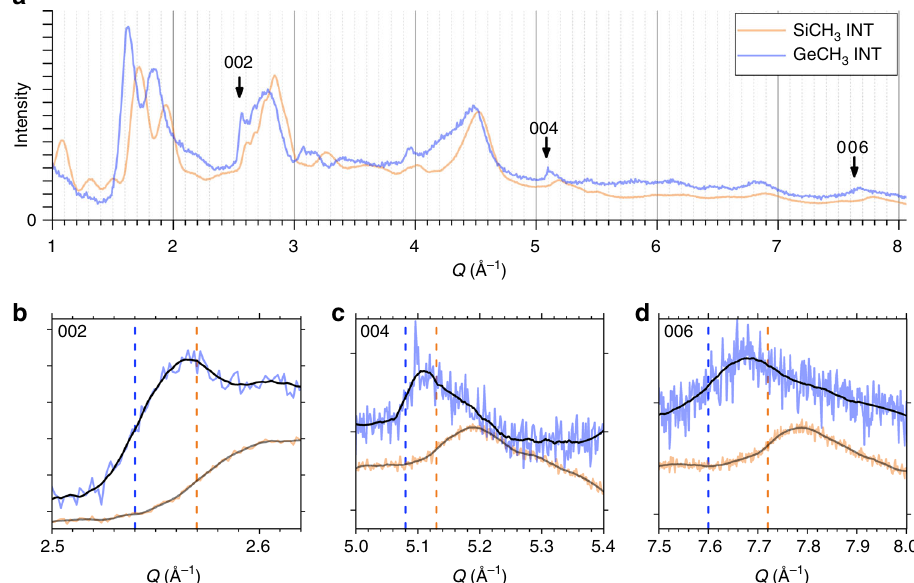
Fig. 3 The period of methylated imogolite nanotube from powder WAXS diagrams. a WAXS of methylated Si(Ge)CH 3 INT powders. Insets b – d highlight 00 l asymmetrical peaks. Black curves are the result of the Savitzky-Golay fi lter, the number of points in the smoothing window is 15 (resp. 20) for 002, 40 (resp. 50) for 004, 60 (resp. 120) for 006 for SiCH 3 (resp. GeCH 3 ) INT. Ten points correspond to 0.01 Å −